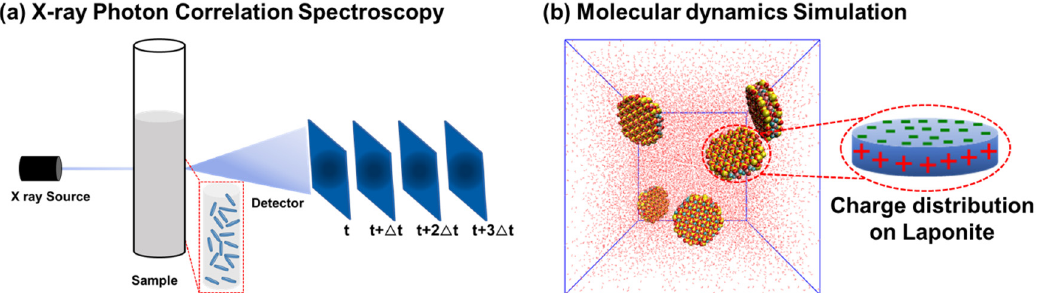
Figure 1. Schematic representation of the experimental setup for X-ray Photon Correlation Spec- troscopy (XPCS) measurements for the laponite suspensions is shown in ( a ). Snapshot of the simulated initial configuration showing the laponite nanoparticles dissolved in water molecules and schematics illustrating the charge distribution on laponite particles shown in ( b ). Laponite nanoparticles are shown in VDW representation mode while water molecules are shown in Lines representation mode implemented in VMD software. Water molecules and laponite nanoparticles are initially randomly distributed in the simulation cell to avoid any bias in the following equilibration